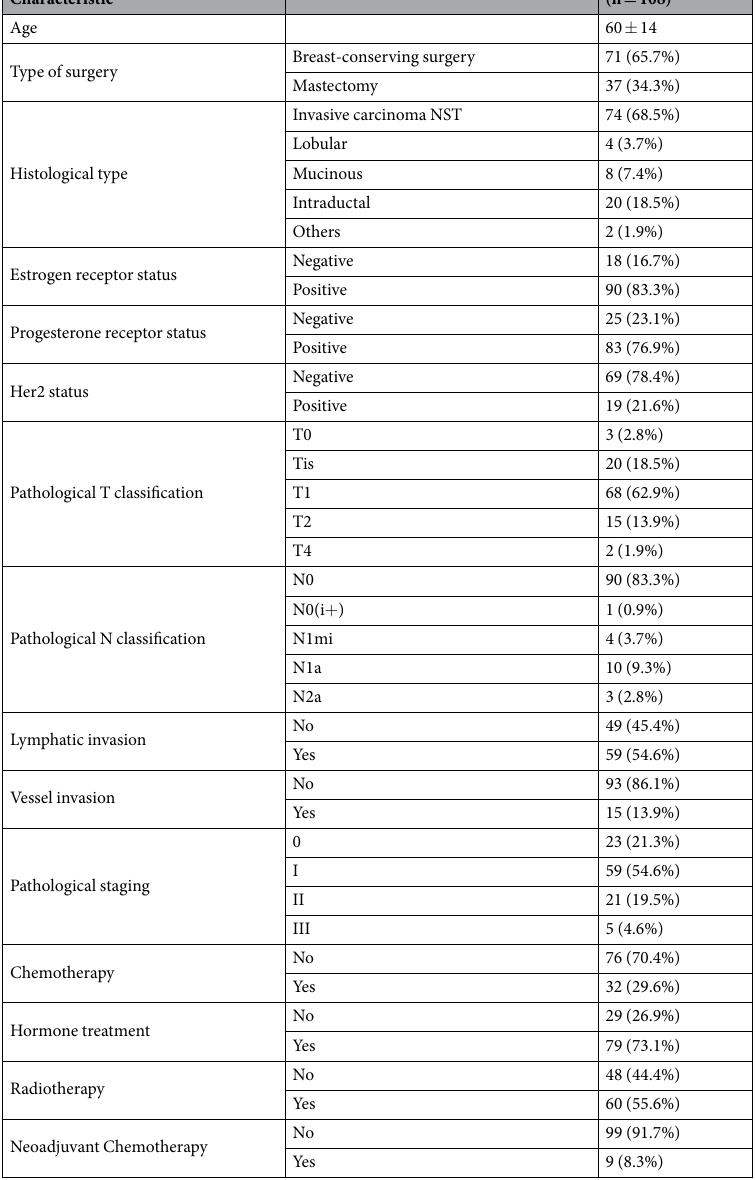
Table 2. Clinical details of these breast cancer patients.